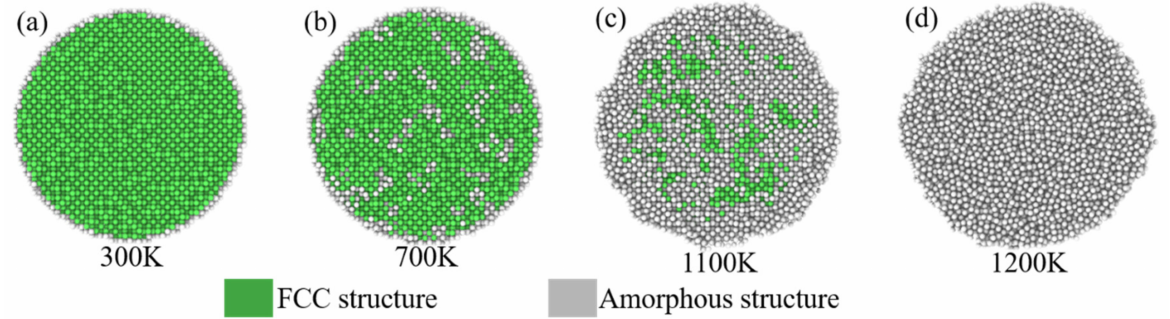
Figure 5. Structural evolution of SP-10 during the melting process heating from 300 K to 1200 K ( a – d